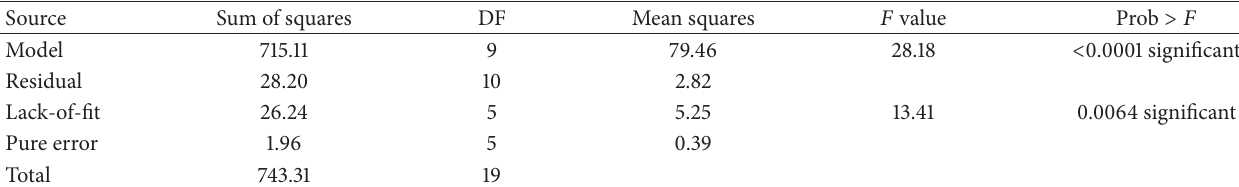
Table 4: Analysis of variance for the quadratic model of tensile strength.